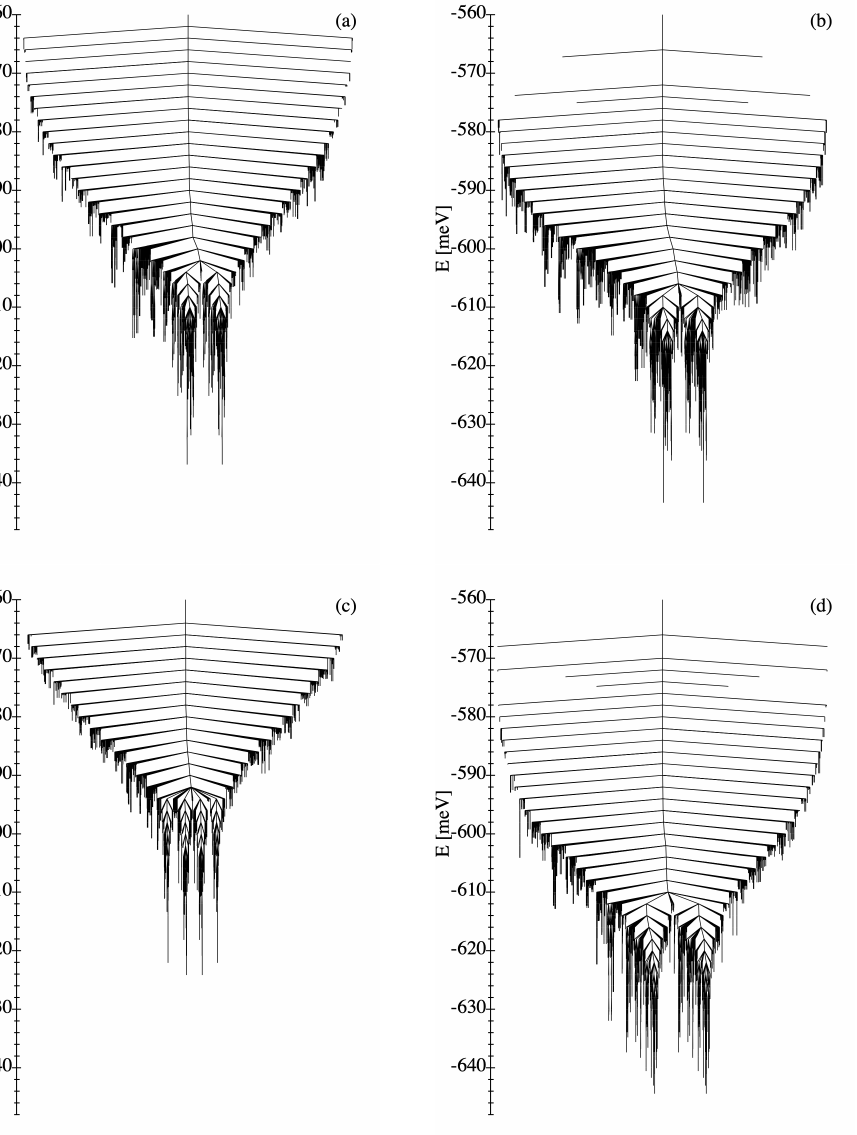
Figure 7. Disconnectivity graphs of energy landscapes of the strongly-disordered ensembles ( a – d